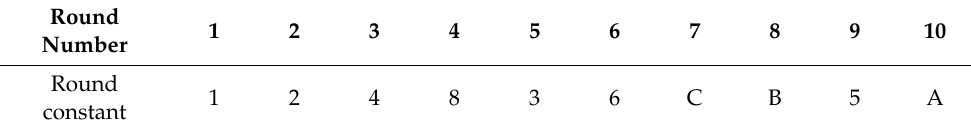
Table 7. Round constant